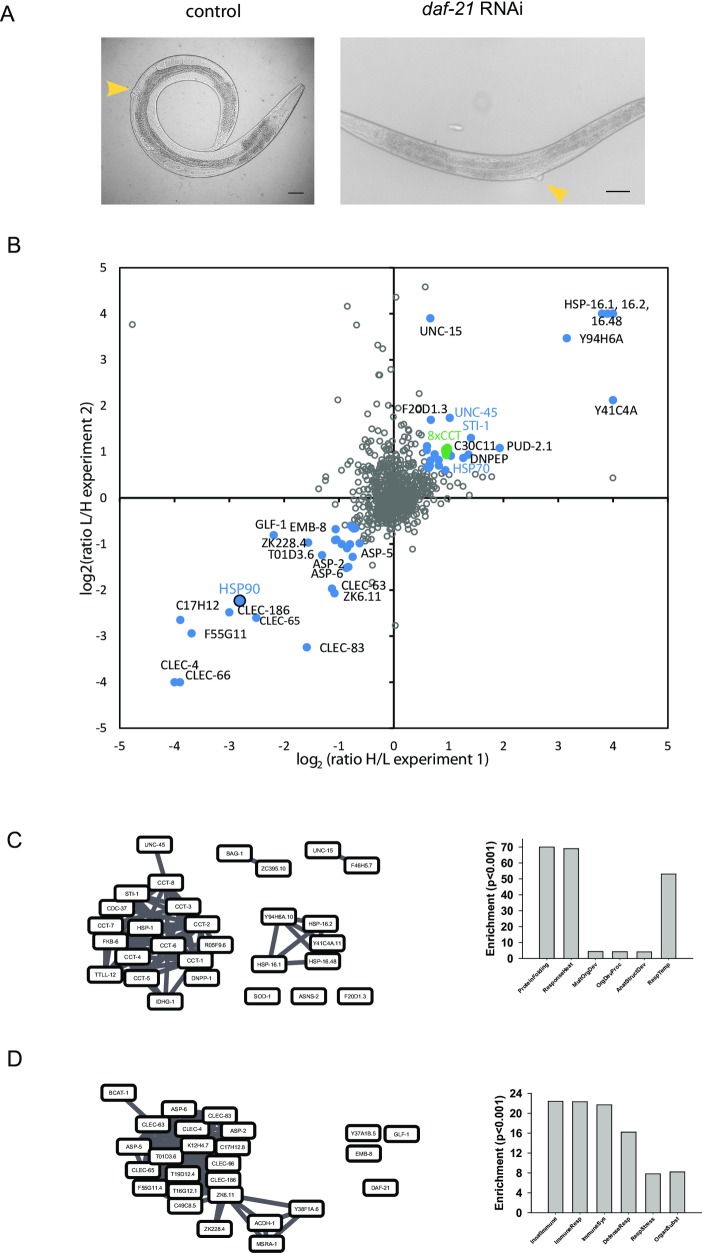
Influence of Hsp90-depletion on the C. elegans proteome.A) Control and Hsp90 RNAi treated N2 nematodes at the moment of harvesting for analysis. The developing phenotype can be seen at the vulva site (yellow arrow) and the Hsp90-depleted nematodes are slightly smaller at that stage. B) Proteomic changes based on isotope-labelled mass spectrometry. The two independent experiments are plotted in the two dimensions. Blue spots indicate genes, for which the identification scores based on the number of detected peptides imply a reliable quantification. C) Network of upregulated proteins and corresponding GO enrichment analysis. The network was generated based on hit-to-hit relationships in a coexpression database as described in the Materials and Methods section. D) Network of downregulated proteins and corresponding GO enrichment analysis. The network was constructed with identical settings as in C.